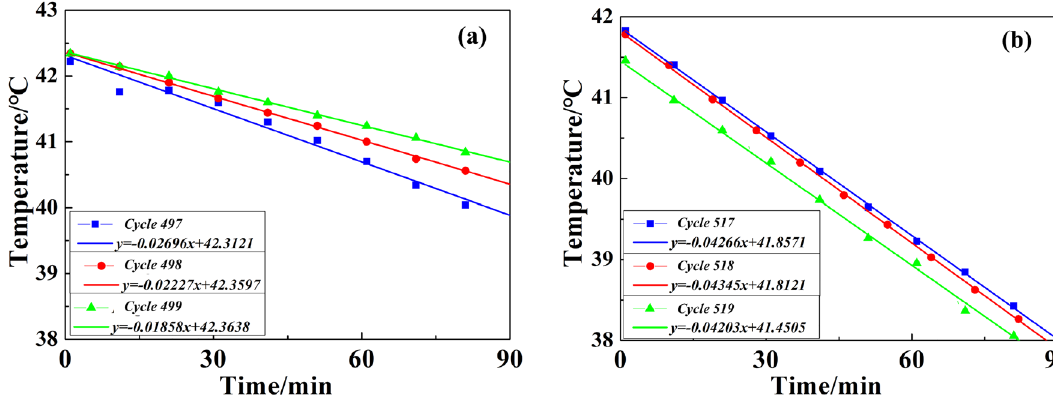
Figure 16. Temperature change regression curve: ( a ) first, ( b ) second.